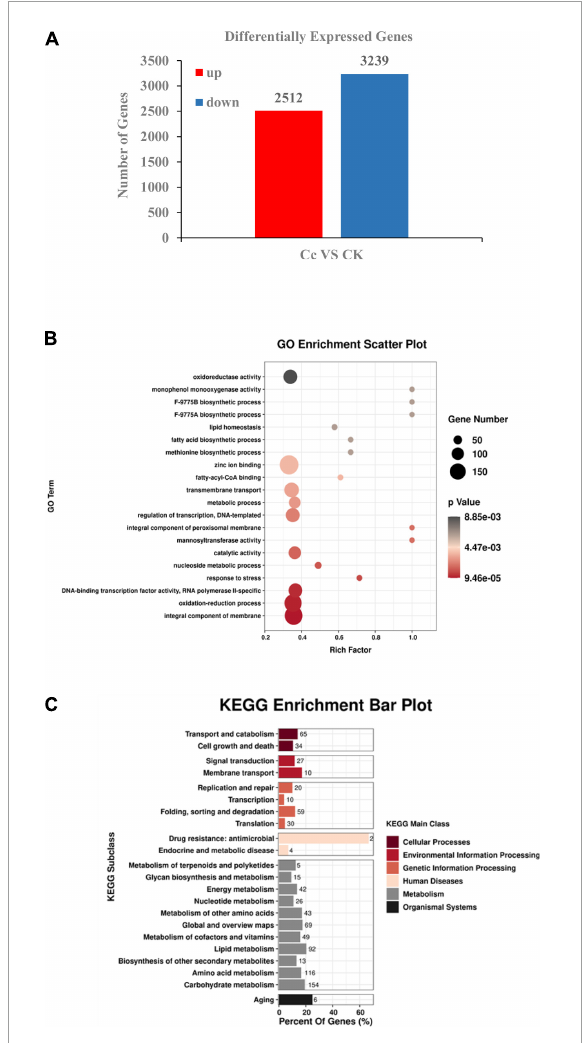
FIGURE1 Transcriptomic analysis revealed differentially expressed genes in C. camelliae CCA during infection tea plant. (A) Numbers of differentially expressed genes ( ≥ 2-fold; p ≤ 0.05) in C. camelliae at 24 h after interaction with tea plant (Cc) or without interaction with tea plants (CK) by RNA-seq. (B) GO analysis of differentially expressed genes in C. camelliae during infection tea plant. (C) KEGG analysis of differentially expressed genes in C. camelliae during infection tea